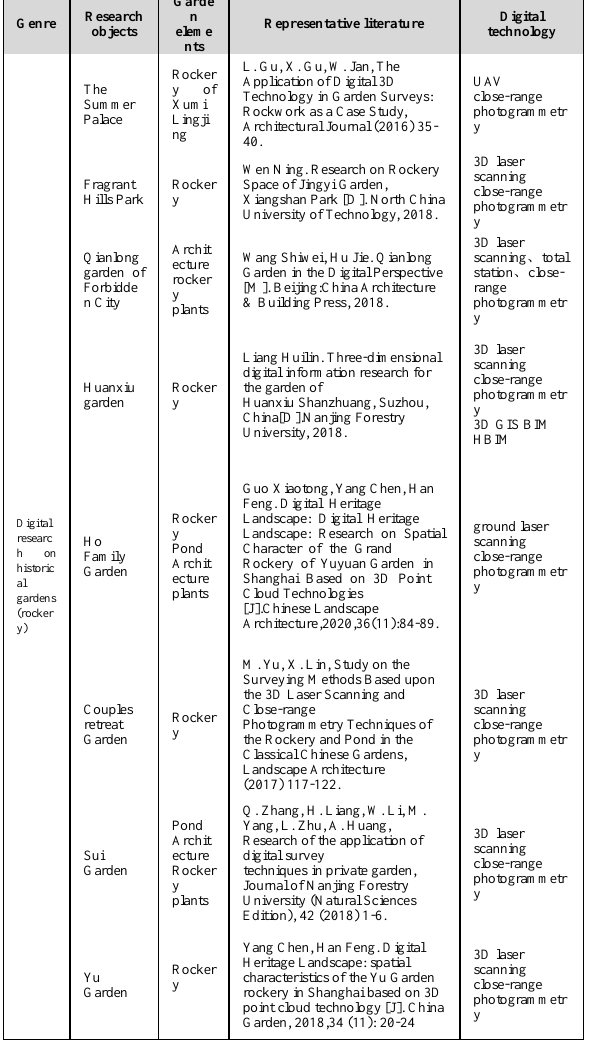
Table 1 . Summary of the key literature of domestic historical garden digitization research in recent years.